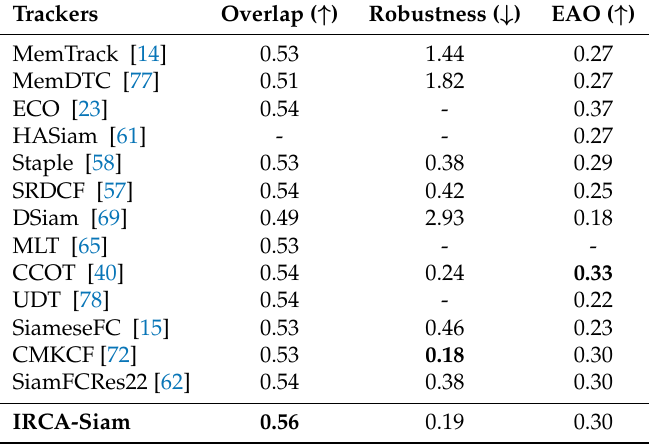
Table 4. Performance comparison for different trackers over